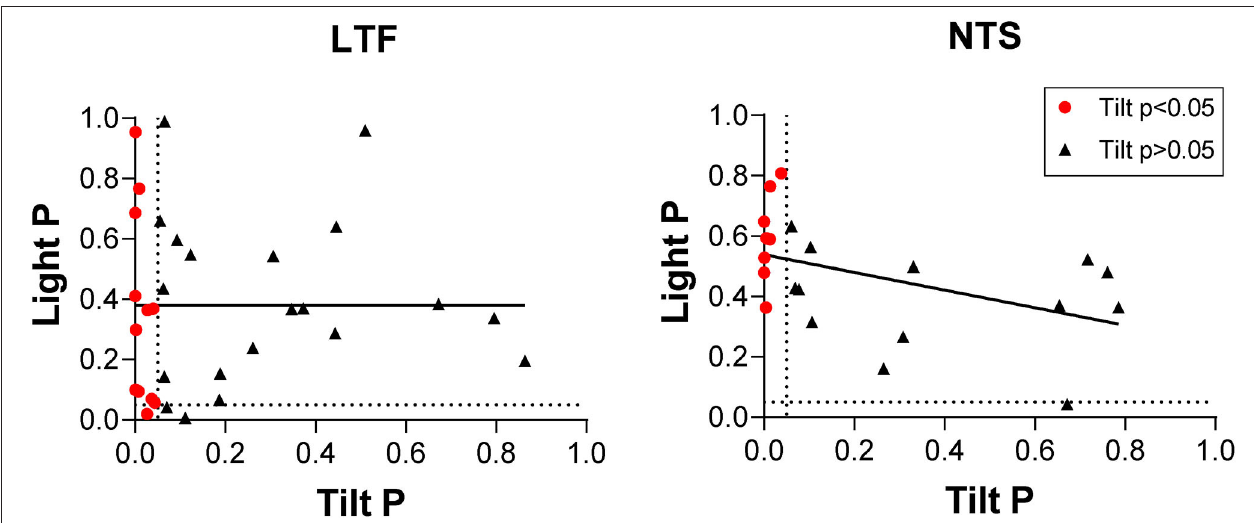
FIGURE 9 | Comparison of P -values (two-tailed t -test) for responses to head-up tilt (Tilt P) and responses to the light cue preceding tilts (Light P, pre-tilt vs. post-2 period indicated in Figure 1 ). Data for neurons with significant responses ( P < 0.05) to head-up tilts are indicated by red symbols. Lines show the best-fit of the data with a linear regression